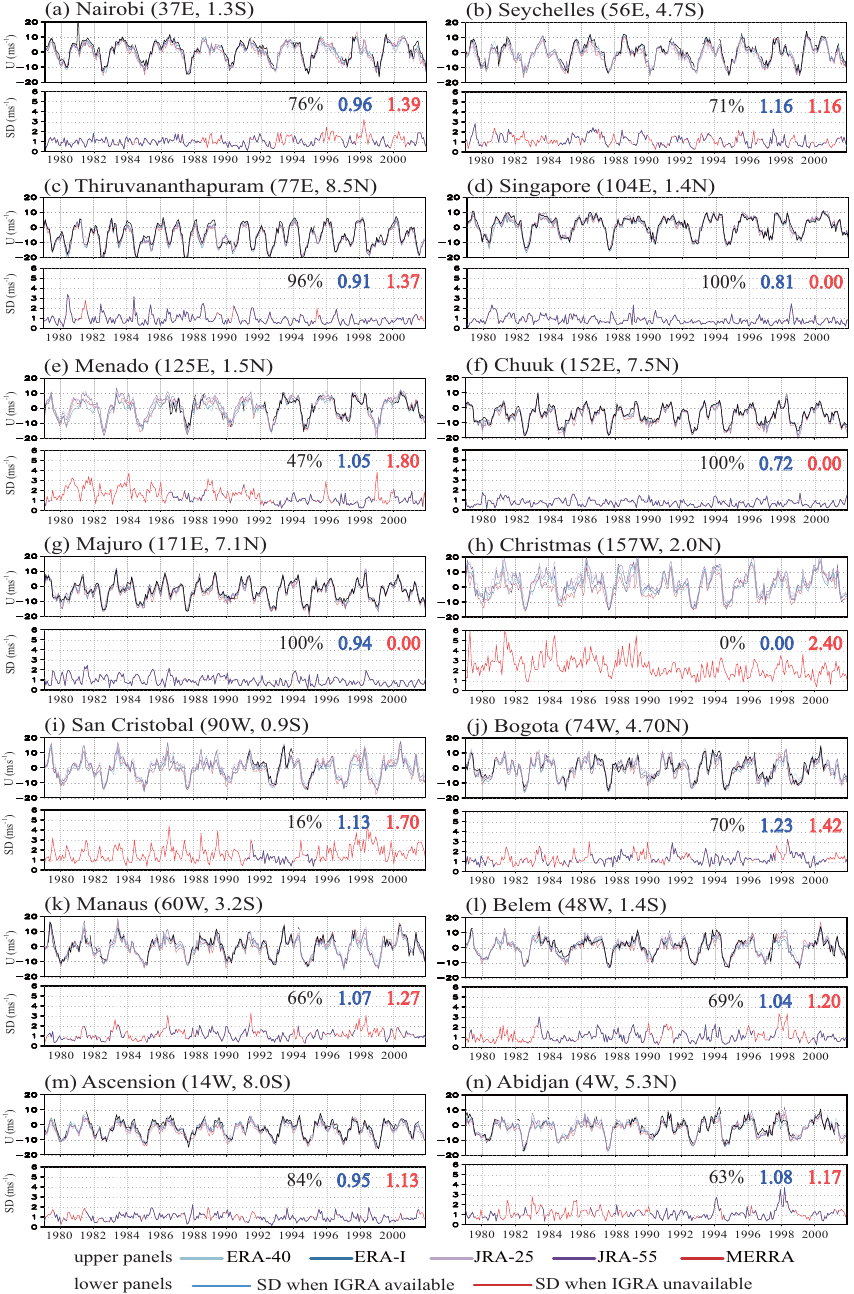
Figure 6. Upper panels show observed zonal wind (black) at each station and reanalysis zonal wind (color) at 70hPa interpolated to each observational point from 1979 to 2001. Lower panels depict standard deviation among the five reanalyses at 70hPa. Blue lines show the standard deviation during times when monthly-mean radiosonde data are available and red lines show the standard deviation during times when they are not. In the upper right corner of each bottom panel, the total data coverage (%) at each station and the average value of the standard deviation during periods with (blue number) and without (red number) radiosonde data are